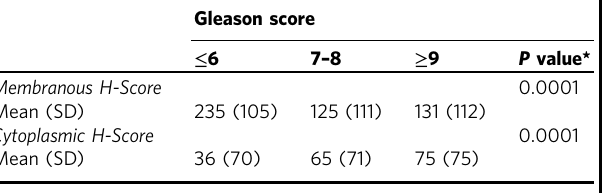
Table 3 H-scores of membranous and cytoplasmic